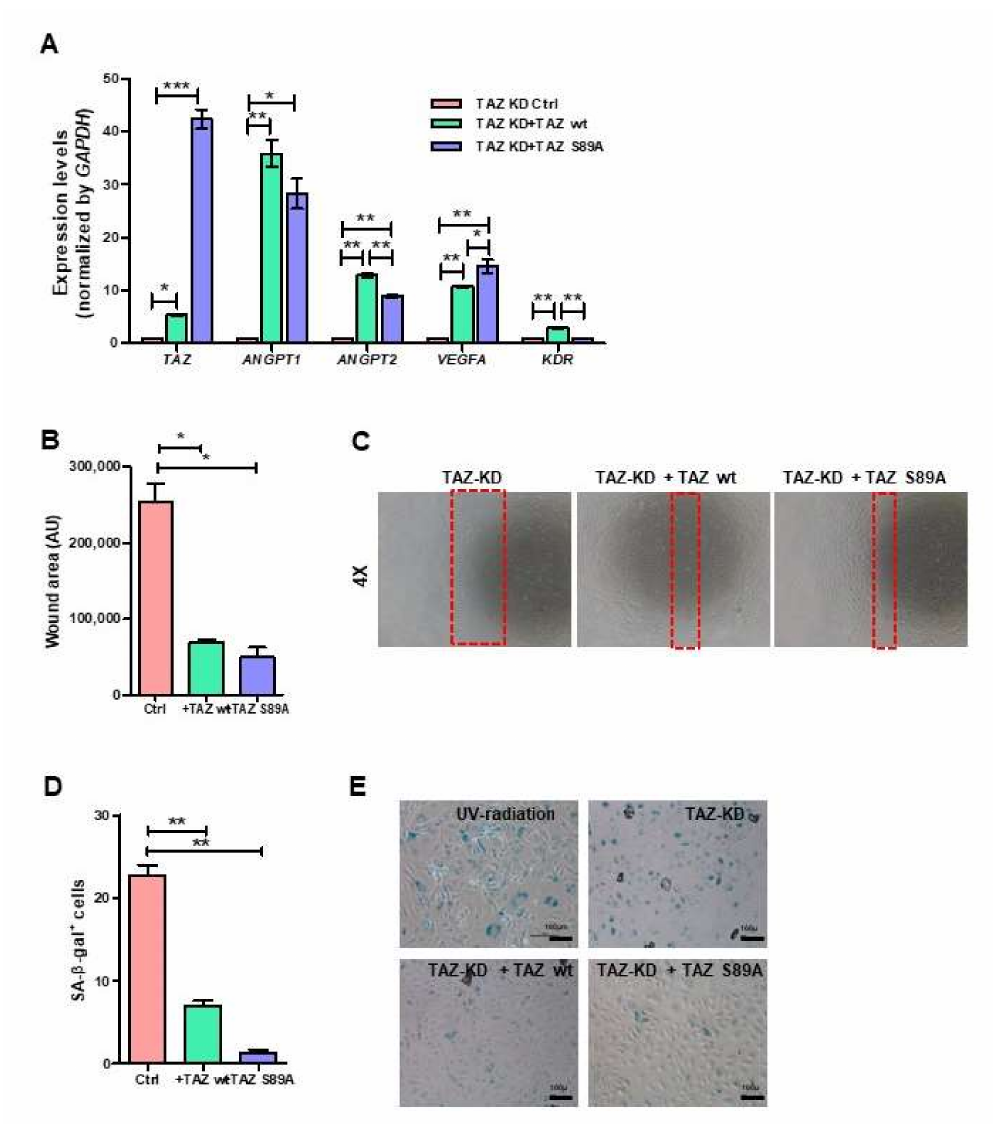
Figure 7. Rescue endothelial cell functions by ectopic expression of TAZ. TAZ-KD EPCs were nucleofected with wild-type or mutant S89A TAZ plasmids. mRNA of endothelial cell-related genes was quantified by RT-qPCR ( A ). Migration was measured by scratch-wound assay ( B , C ). Senescence cells were scored by enzymatic detection of positivity of β -galactosidase activity ( D , E ). All experiments were performed three times independently with technical duplicates, and data were expressed as mean ± SEM. * p -value < 0.05; ** p -value < 0.01; and *** p -value <